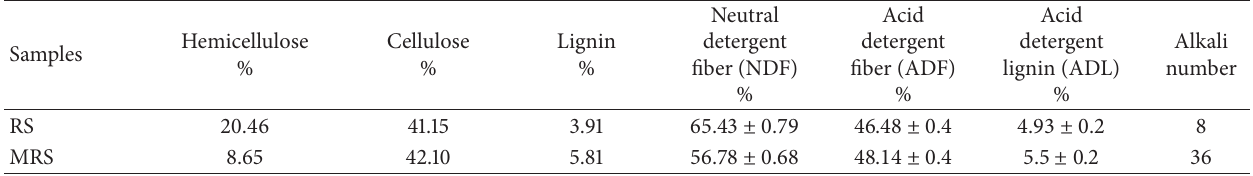
Table 1: Chemical properties of native and modified rice straw and alkali number.